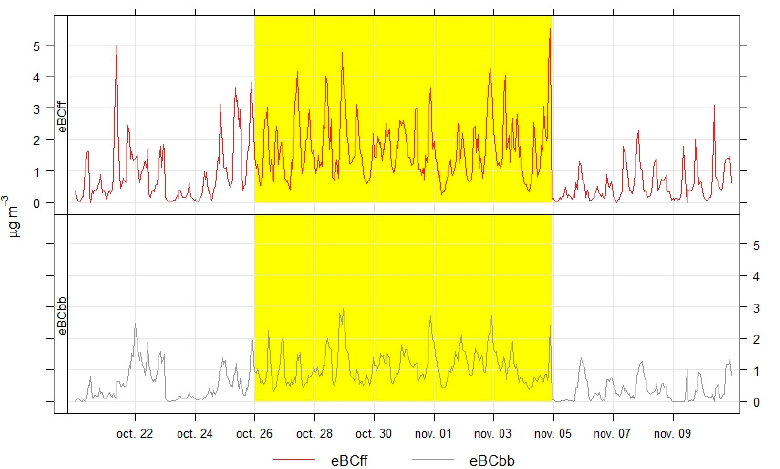
Figure 13. eBCff and eBCbb concentrations during a strong episode of Saharan dust intrusion and biomass combustion from 26 October to 4 November 2016.